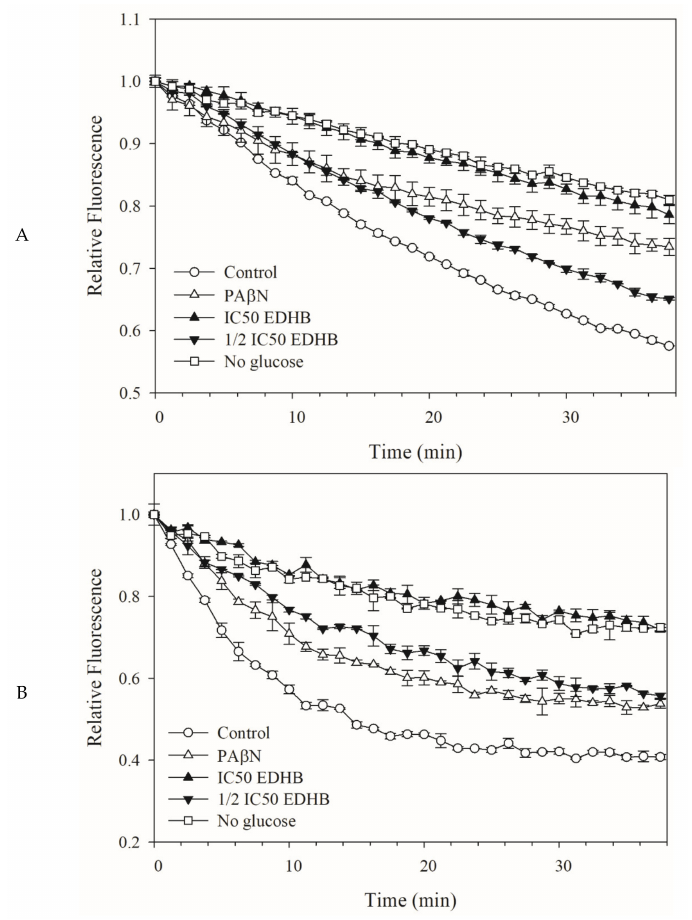
Figure 3. The ( A ) H33342 and ( B ) EtBr efflux assay with EDHB in E. coli Kam3-AcrB. The drug- resistant E. coli cells were added with glucose (25 mM) and H33342 (3 µ M), EB (3 µ M) in the presence or absence of PA β N (20 µ g/mL) or EDHB (IC 50 at 500 µ g/mL). Data are expressed as mean ± SD ( n =